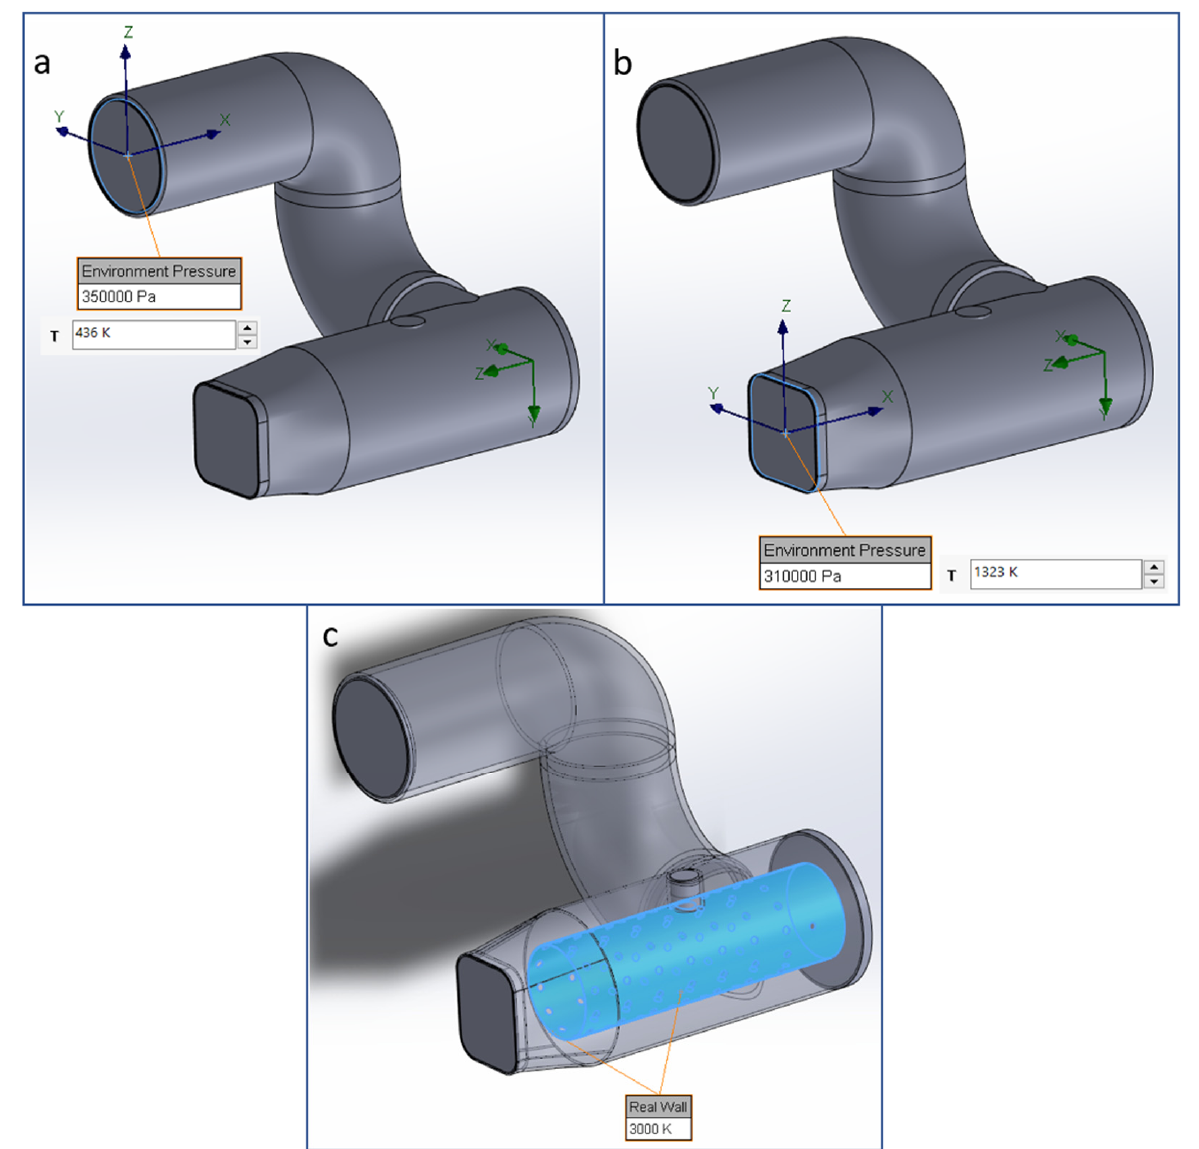
Figure 5. ( a ) Input parameters of the combustor. ( b ) Output parameters of the combustor (turbine intake). ( c ) Perforated sheet temperature .